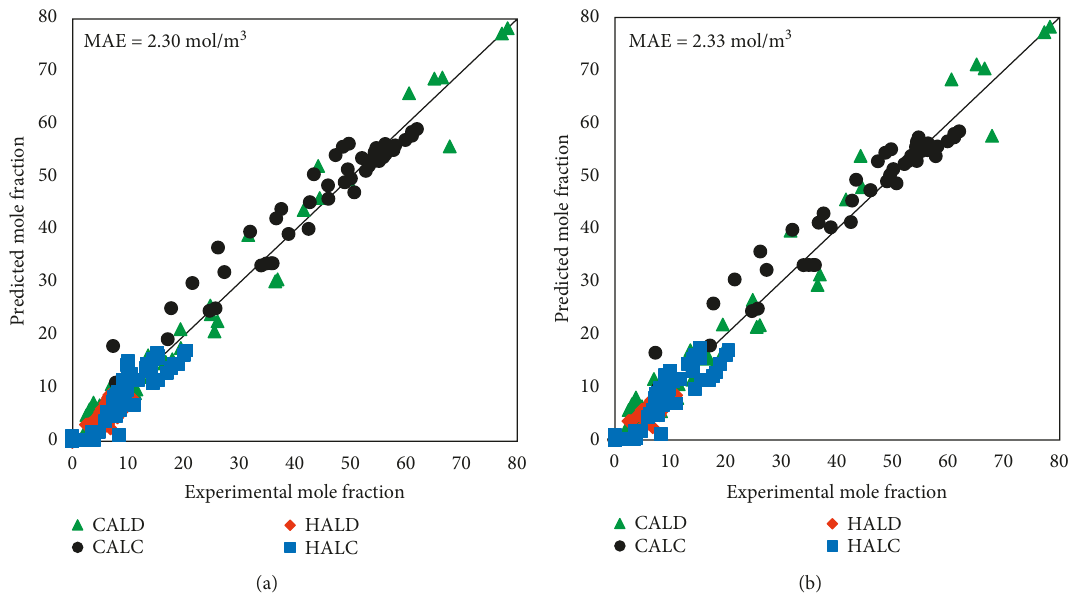
Figure 6: Parity diagram indicating the calculated molar fractions obtained by the (a) bulk and (b) intraparticle diffusion models versus the experimental molar fractions for all experiments and components.